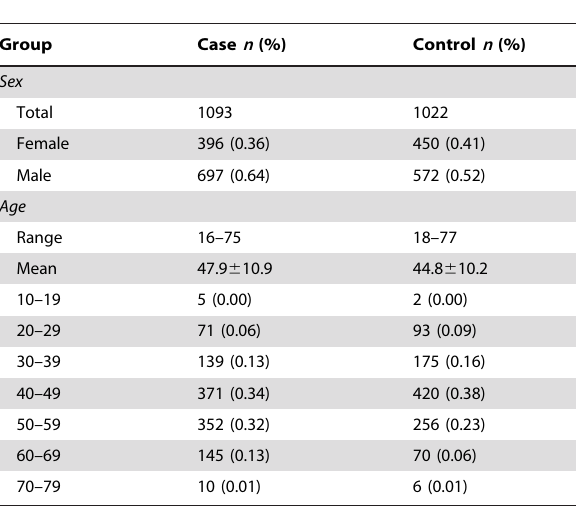
Table 1. Demographic characteristics of study